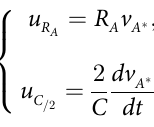
PLOS Computational Biology | https://doi.org/10.1371/journal.pcbi.1008859 May 13,